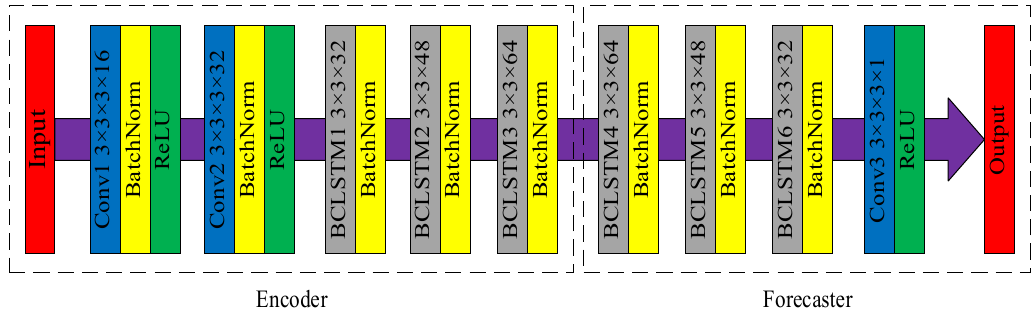
Figure 5. Network structure of encoding ‐ forecasting.